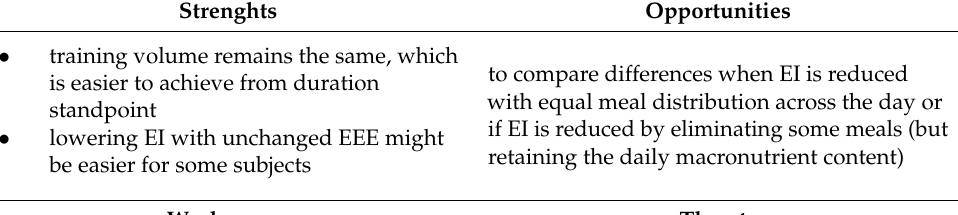
Table 2. SWOT analysis of low-EI protocol (EEE = exercise energy expenditure, EI = energy intake, LEA = low energy availability, EB = energy balance).